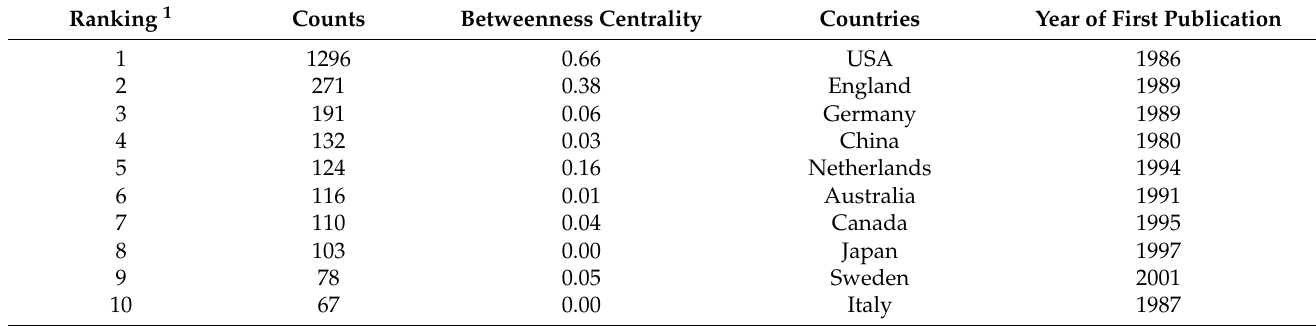
Table 3. Top 10 countries for crisis and risk communication research.